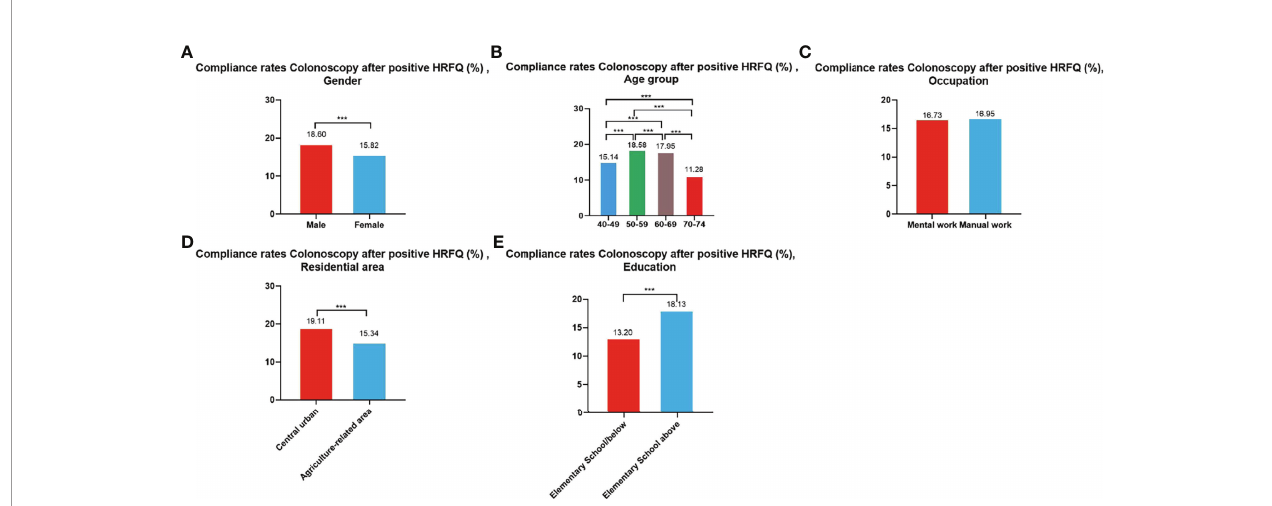
FIGURE 5 | Compliance results by gender (A) , age group (B) , occupation (C) , residential area (D) , education (E) of subsequent colonoscopy in positive HRFQ participants. ***There are signi fi cant differences in detection rates between the different screening methods.